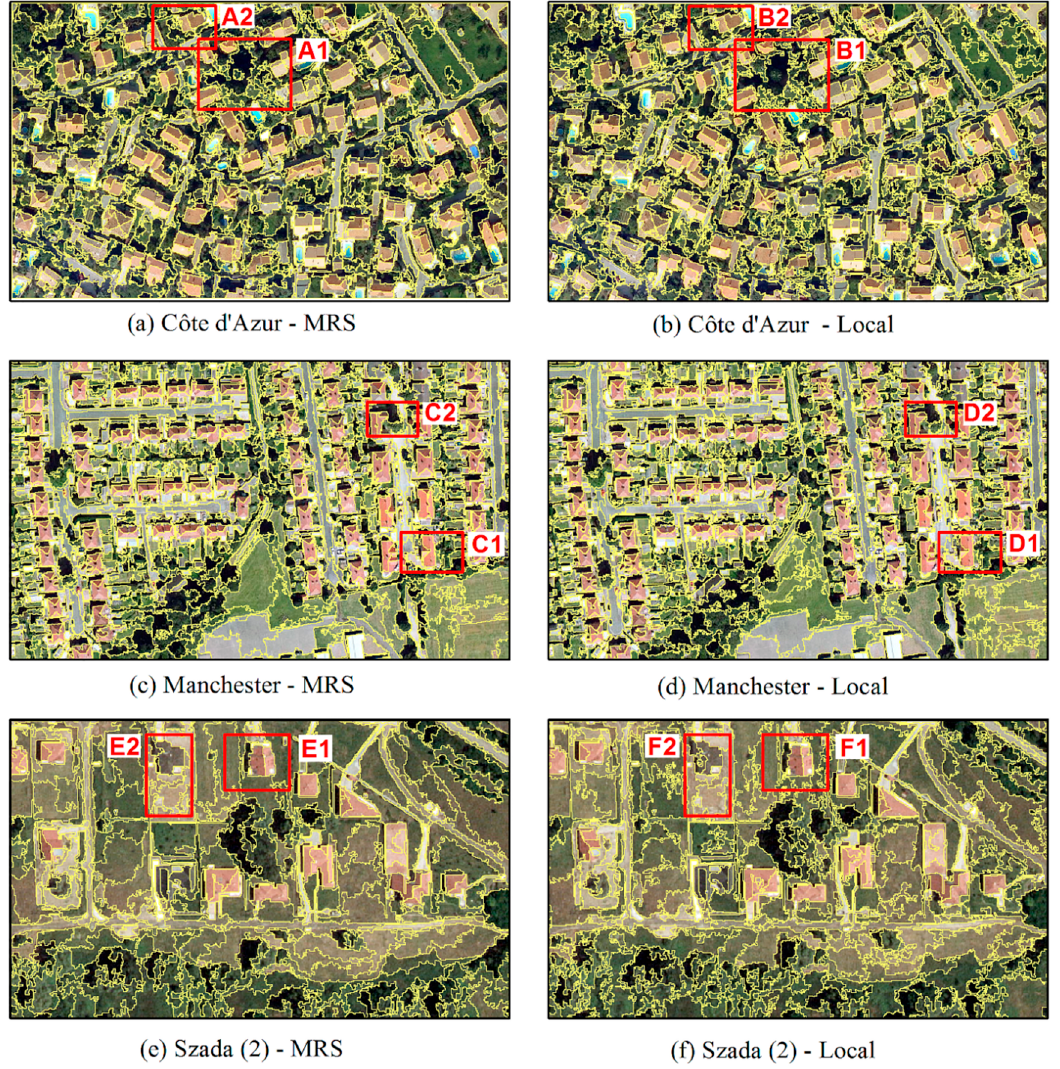
Figure 8. The segmentation results produced by MRS and Local using the SZDAKI-INRIA building detection dataset.